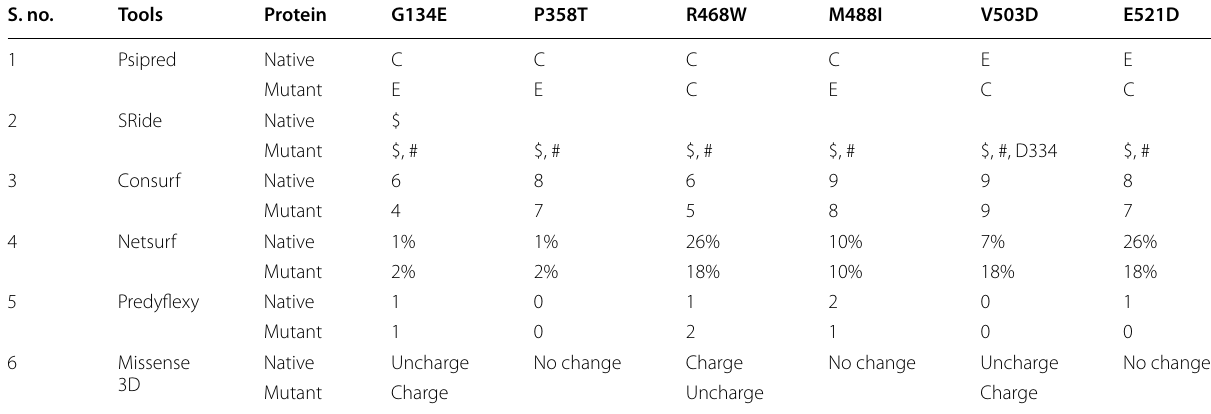
Table 5 Results of trajectory analysis